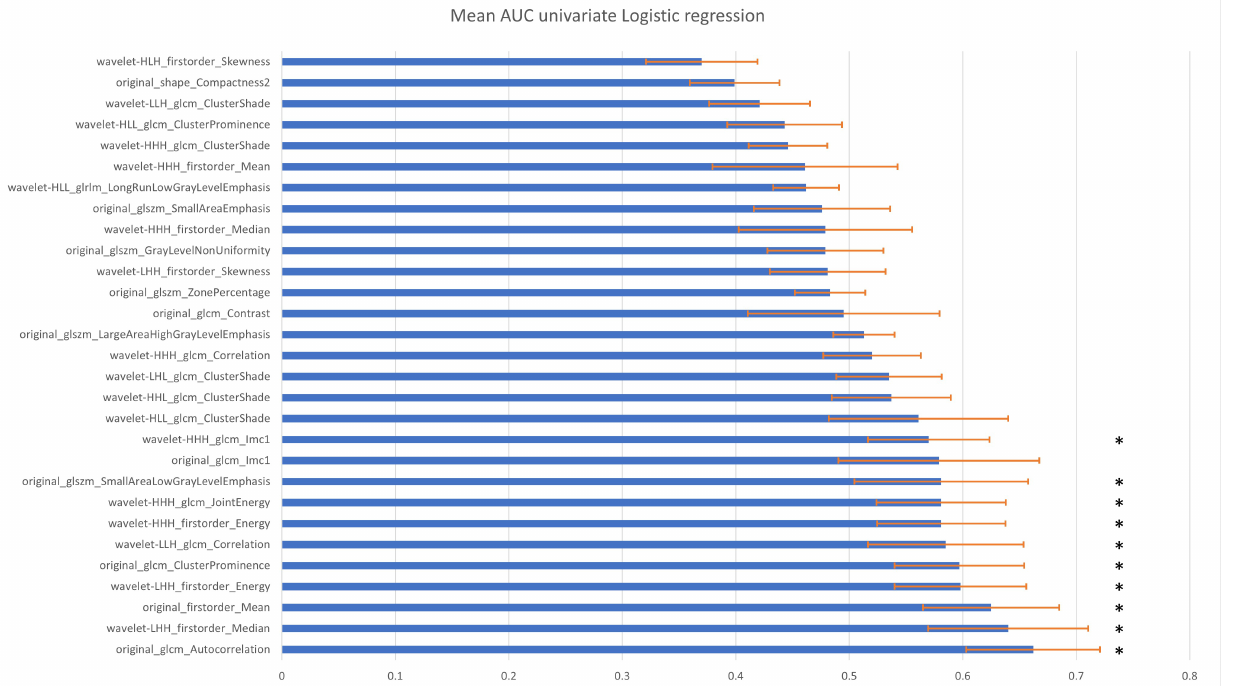
standard deviations. Features marked 2